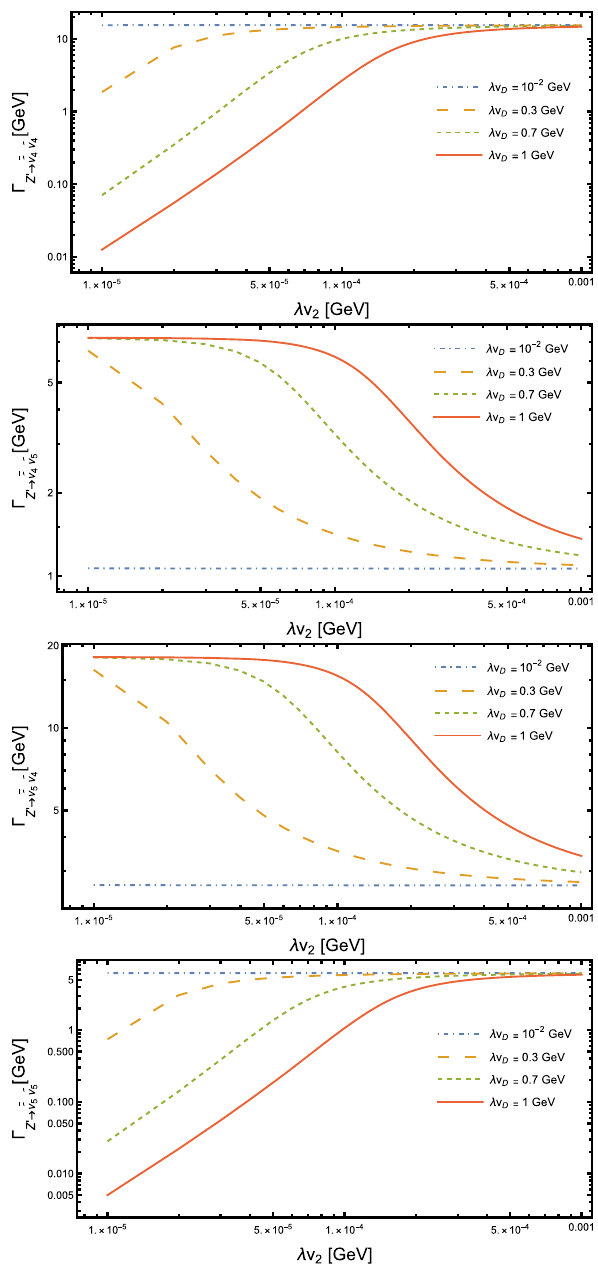
Fig. 7 Z (cid:2) decay rates into ˜ ν i ˜ ν j mixed state with i , j = 4 , 5 as a func- tion of λv 2 for different values of λv D . M Z (cid:2) = 7